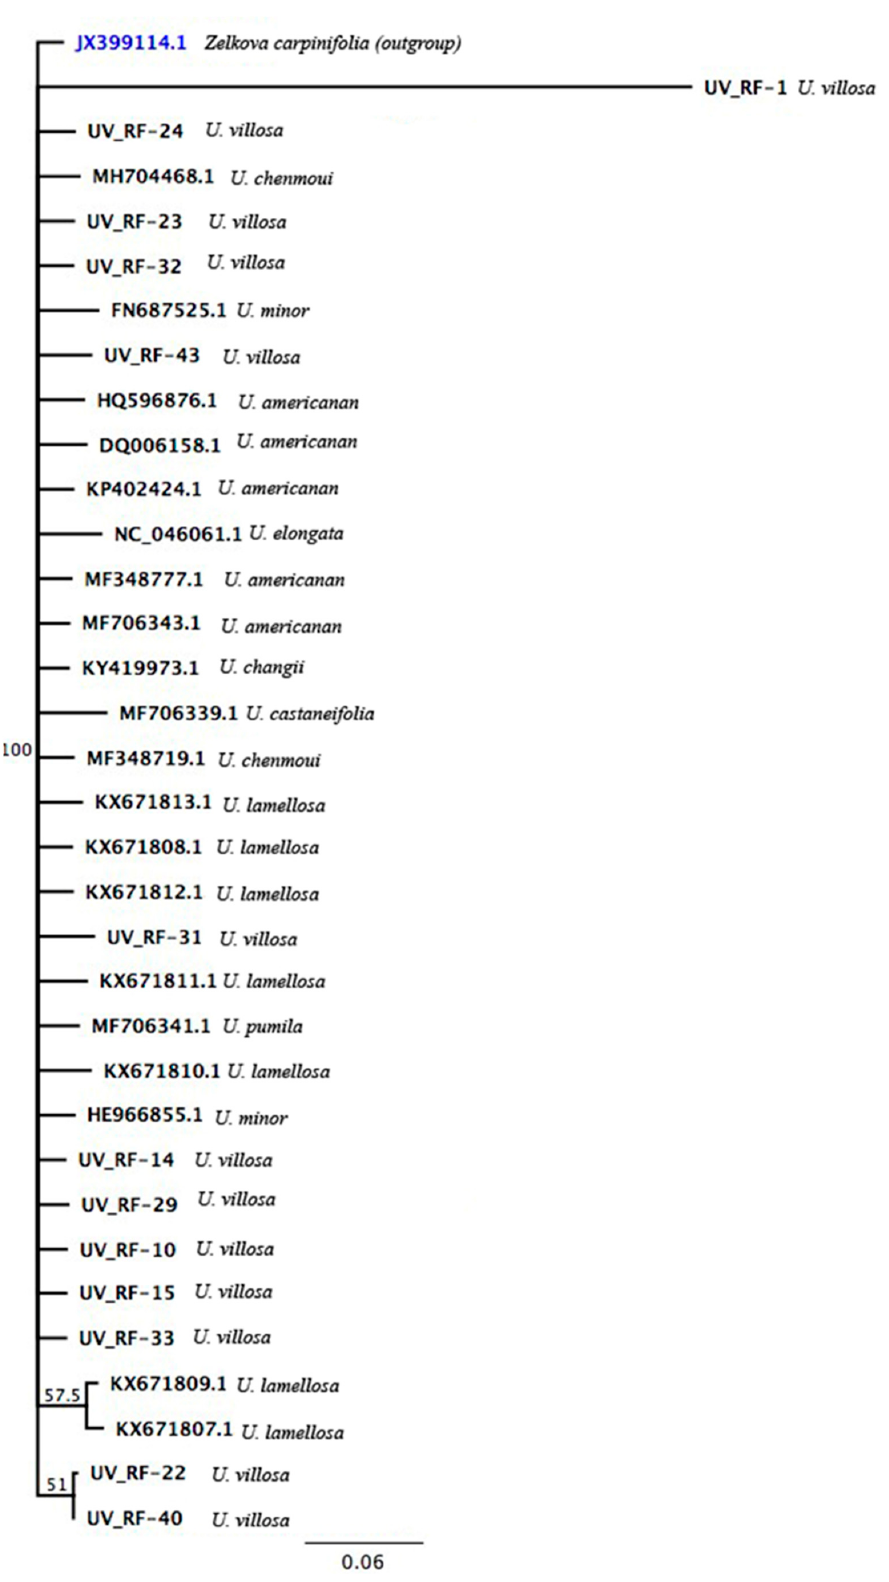
Figure 9. Neighbor joining (NJ) tree based on trnH-psbA region. The bootstrap consensus tree was inferred from 1000 replicates.